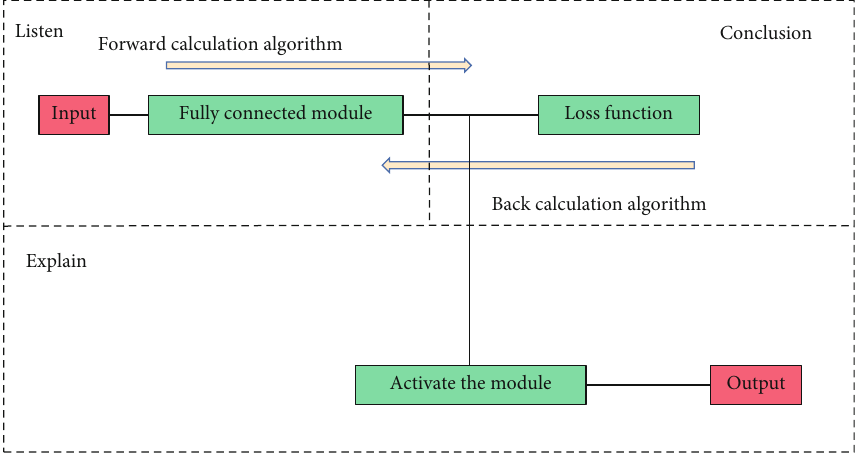
Figure 9: Logic block diagram of adaptive neural network design based on basic teaching design.